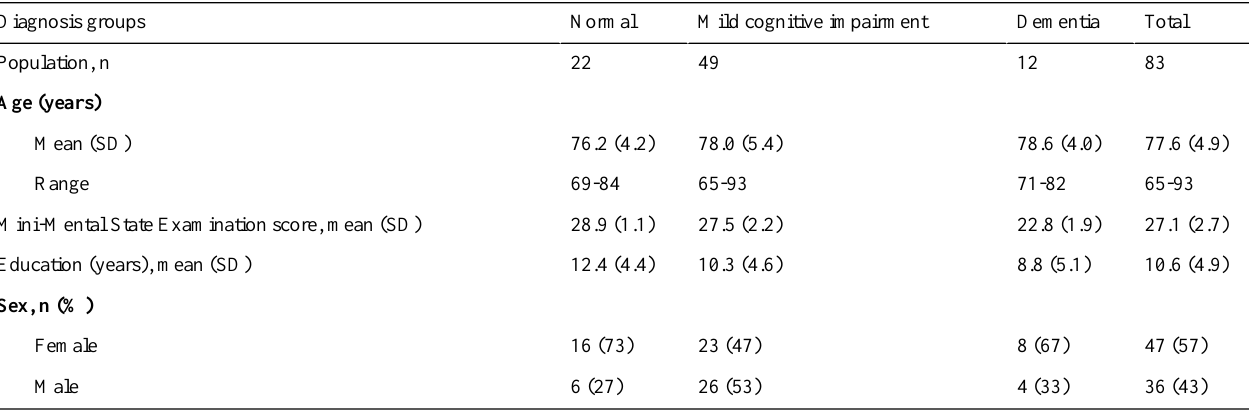
Table 1. Characteristics of the participants (overall and divided into diagnosis groups).